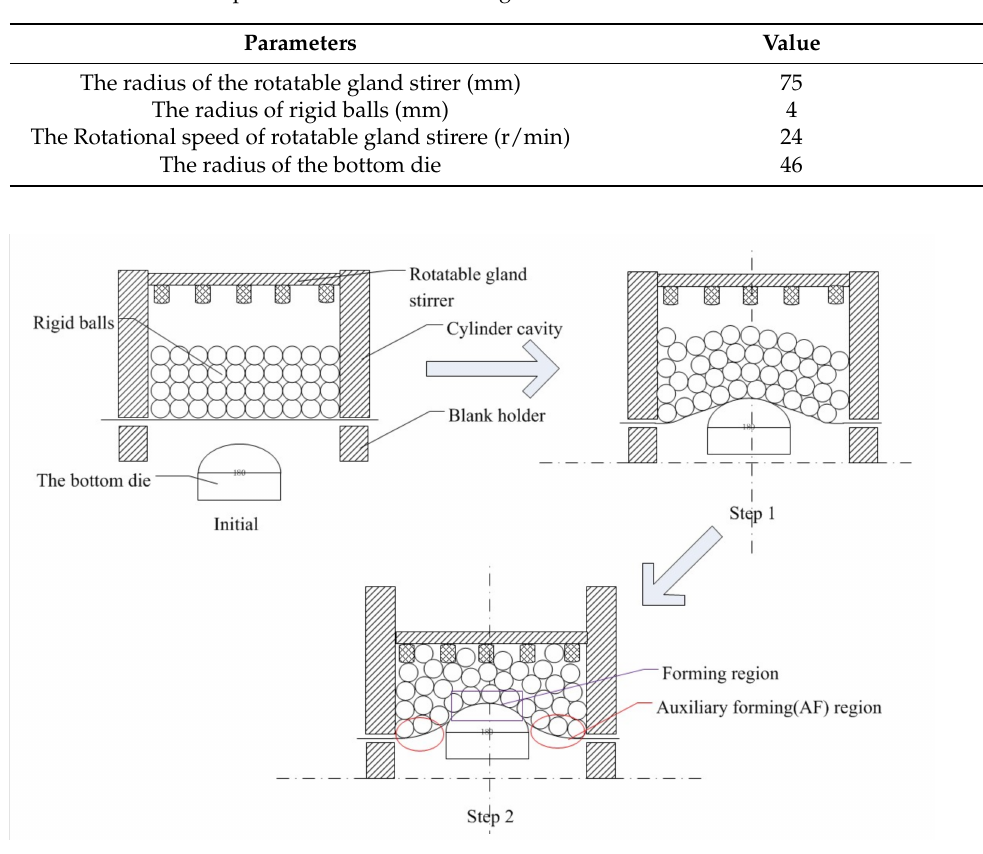
Figure 2. The forming process of